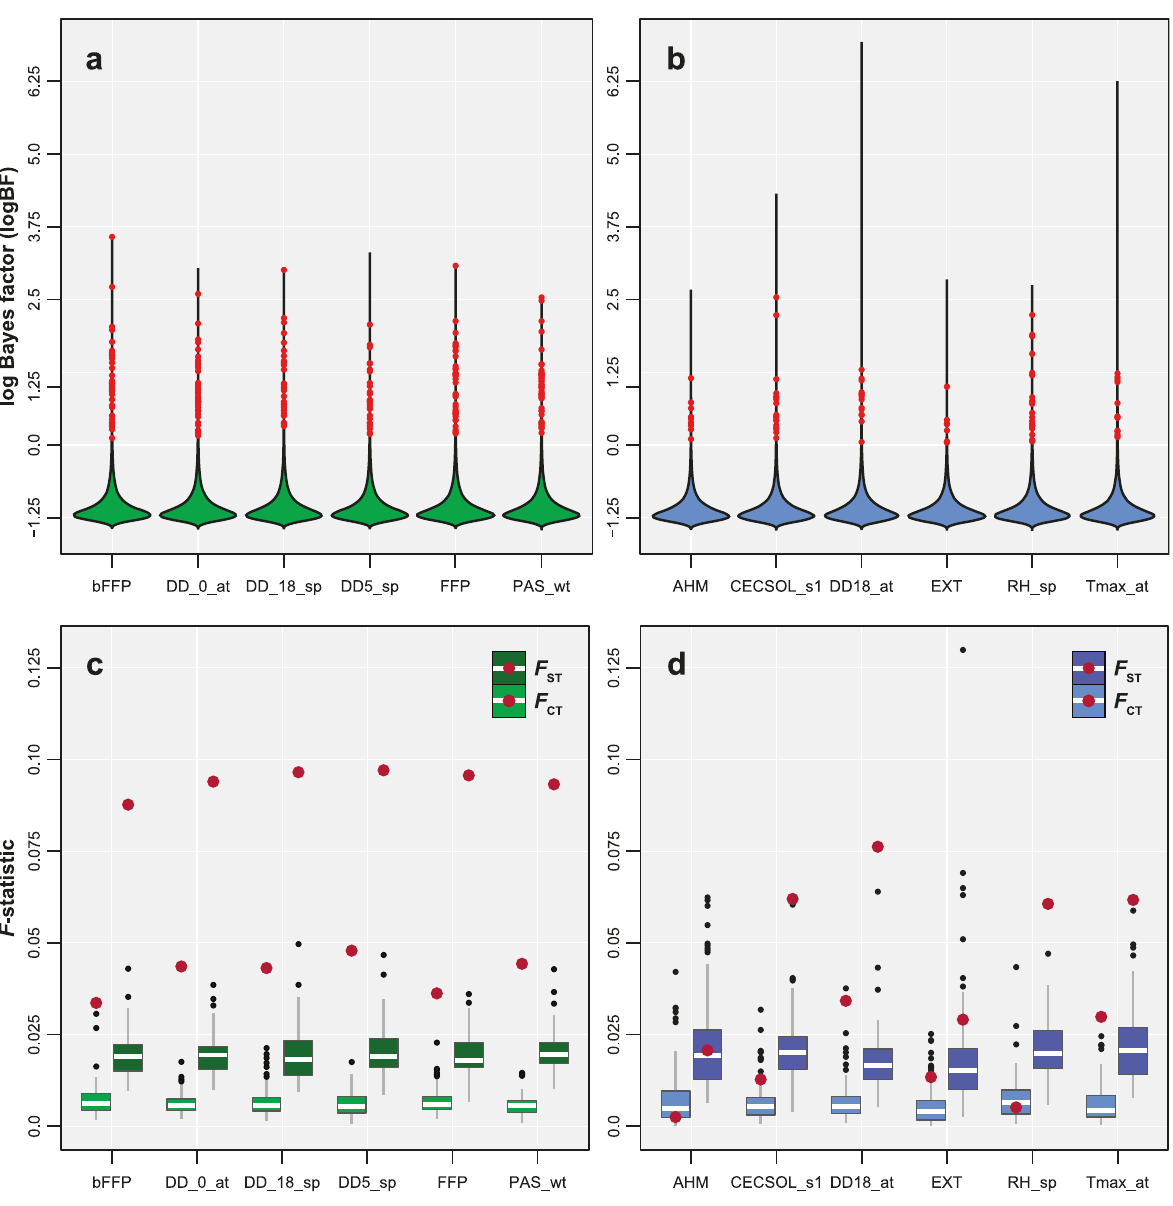
Fig. 2 Distribution of median Bayes factor ( f BF ) values on log scale and multilocus F -statistics for SNPs associated with the least differentiated and most differentiated environmental gradients. Distribution of median Bayes factor ( e BF ) values on the log scale for all 72,889 SNPs for a environmental gradients that strongly differentiate P. fl exilis and P. strobiformis and b environmental gradients that least differentiate the two species. Red dots in the violin plots of e BF indicates outlier SNPs. Bootstrap distributions of multilocus F -statistics ( F ST and F CT ) for c environmental gradients that strongly distinguish P. fl exilis and P. strobiformis and d environmental gradients that are least different between the two species. Red dots in the F -statistics boxplots indicate the observed multilocus estimates for Bayenv outlier SNPs. Boxplots in c and d represent 1000 bootstrapped estimates of multilocus F -statistics for putatively neutral SNPs that were matched on missing data and minor allele frequency to the outlier sets for each environmental gradient. For each boxplot the whiskers represent 1.5 times the inter-quantile range. Note that Supplementary Data 1 lists per environmental range of e BF , not on the log